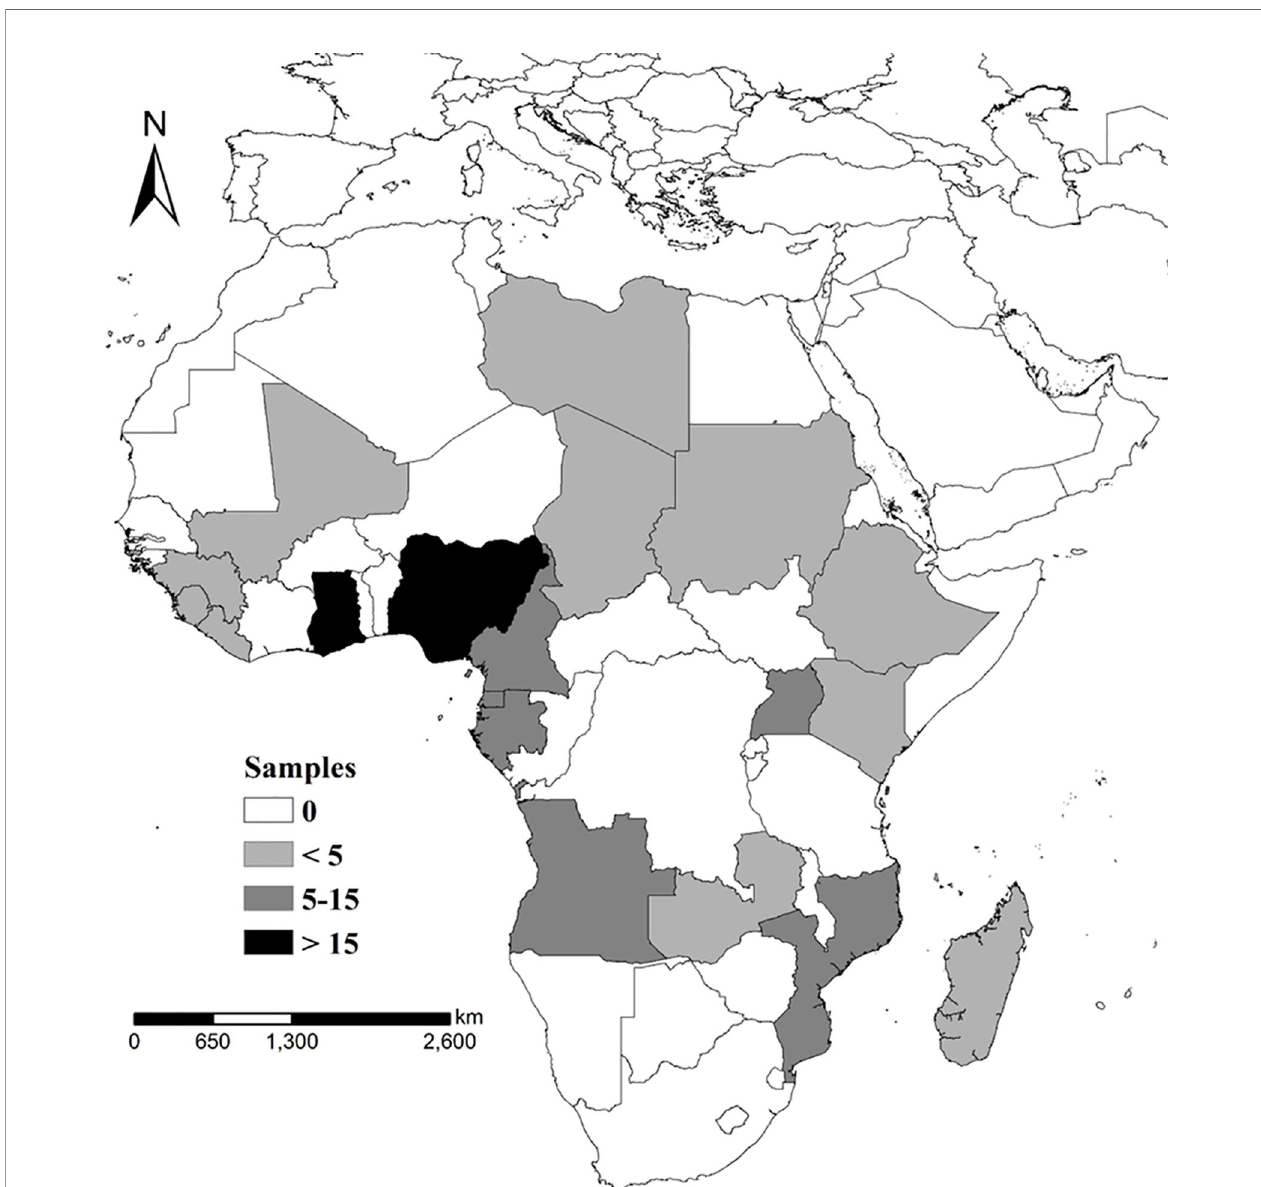
FIGURE 1 | Sample collection and distribution, samples collection sites and sample screening and follow-up analysis of subject